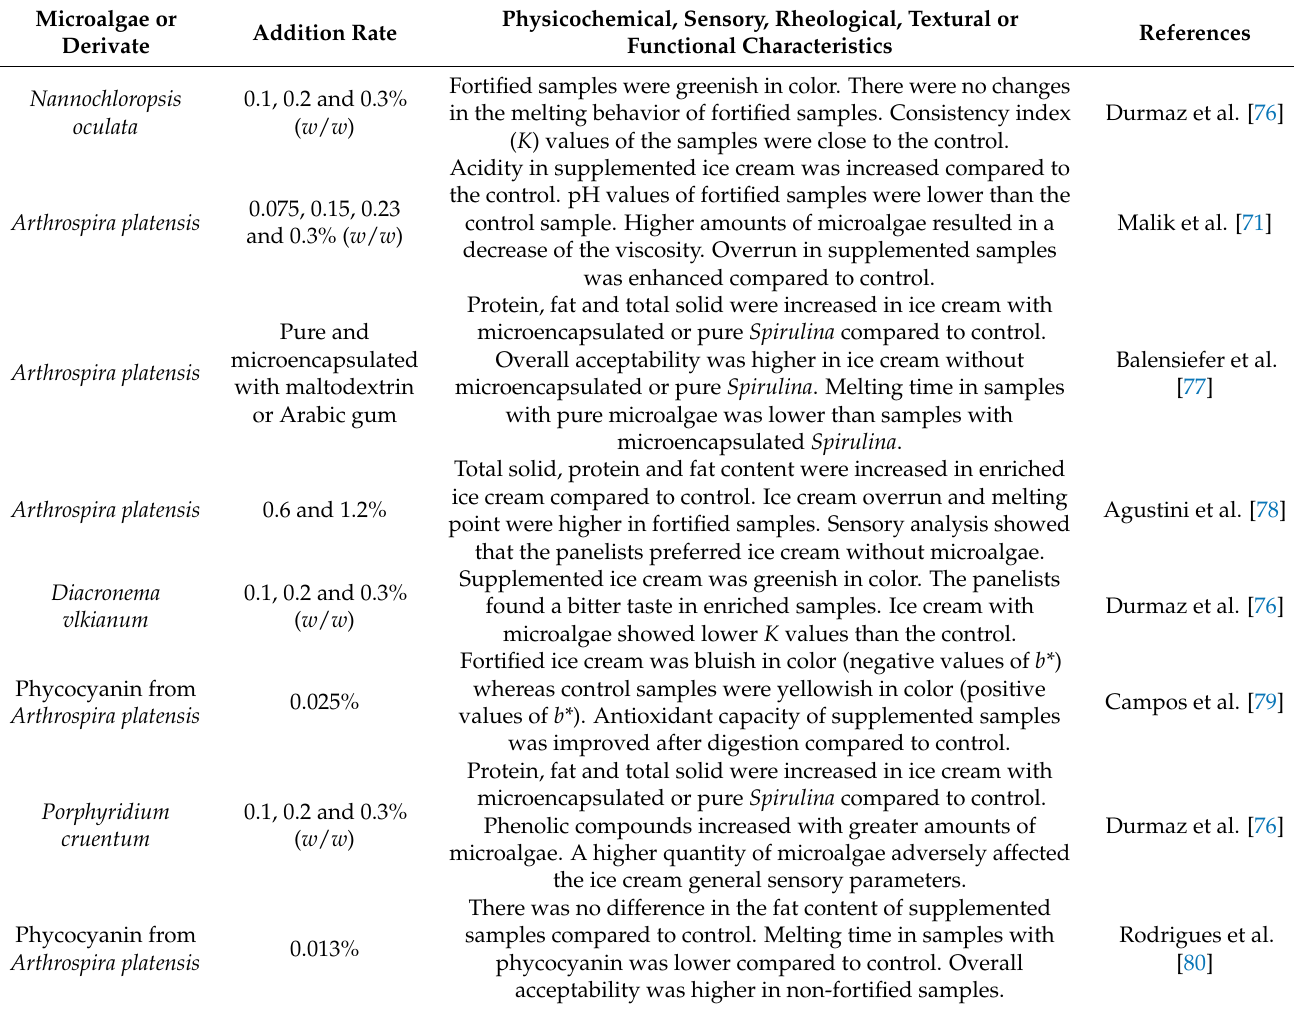
Table 3. Studies on the application of microalgal biomass or derivates in ice